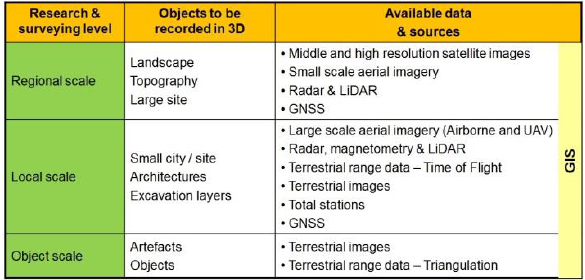
Figure 3: Different research and surveying levels and available data/sensors/techniques for 3D documentation